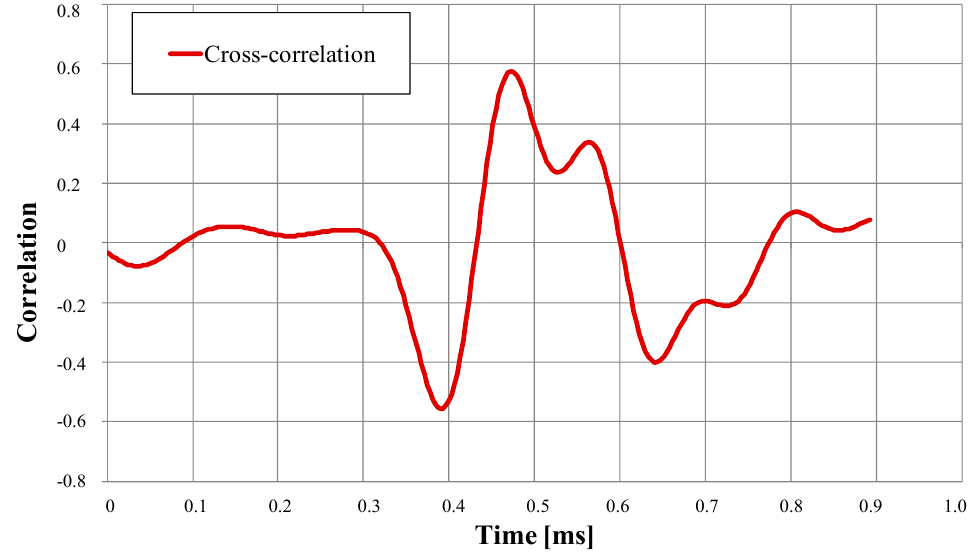
Figure 6. Cross-correlation method. An example of test results from pure RCA specimen No. 2, T = 0.16 ms, p ′ =9 0 kPa.